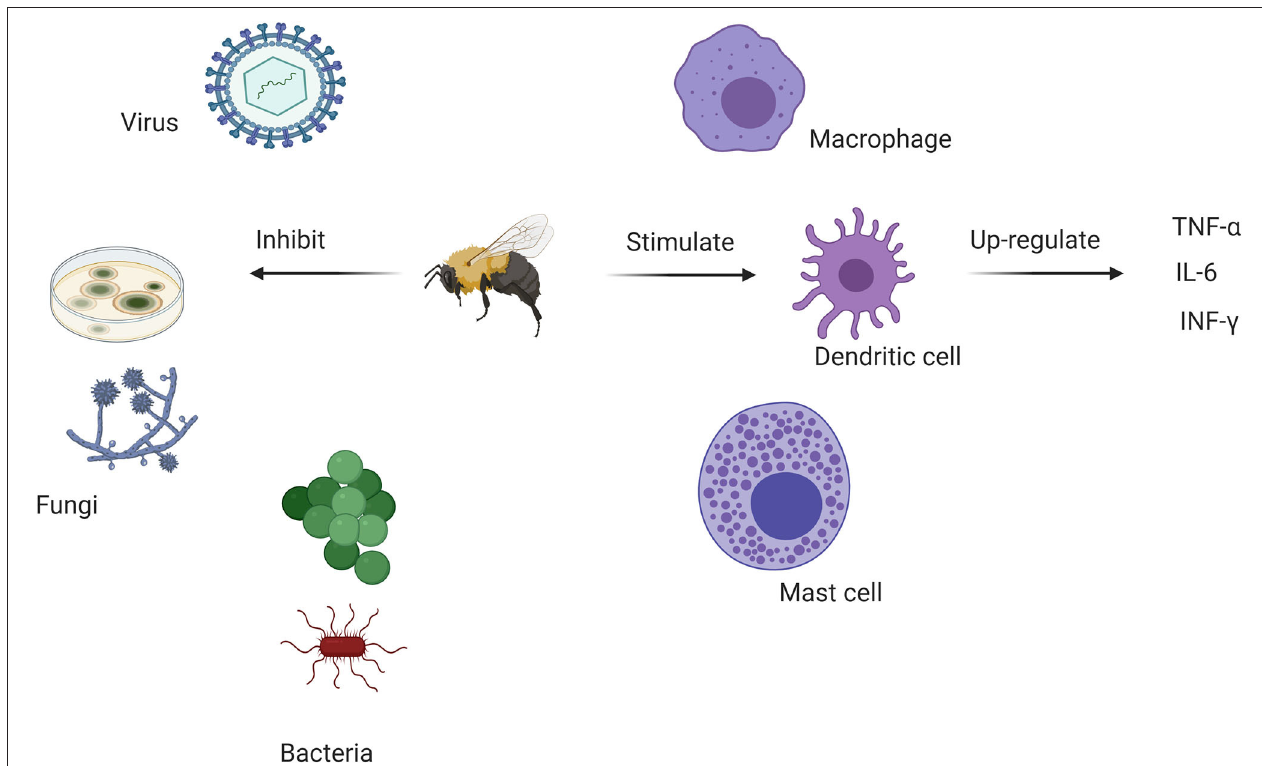
FIGURE 2 | Antimicrobial and immunomodulatory actions of various bee venom components. BV inhibits bacterial, antifungal and viral growth while stimulating dendritic cell activity through major anti-inflammatory cytokines. This offers a rationale for its use in complementary medicine to control the SARS-CoV-2